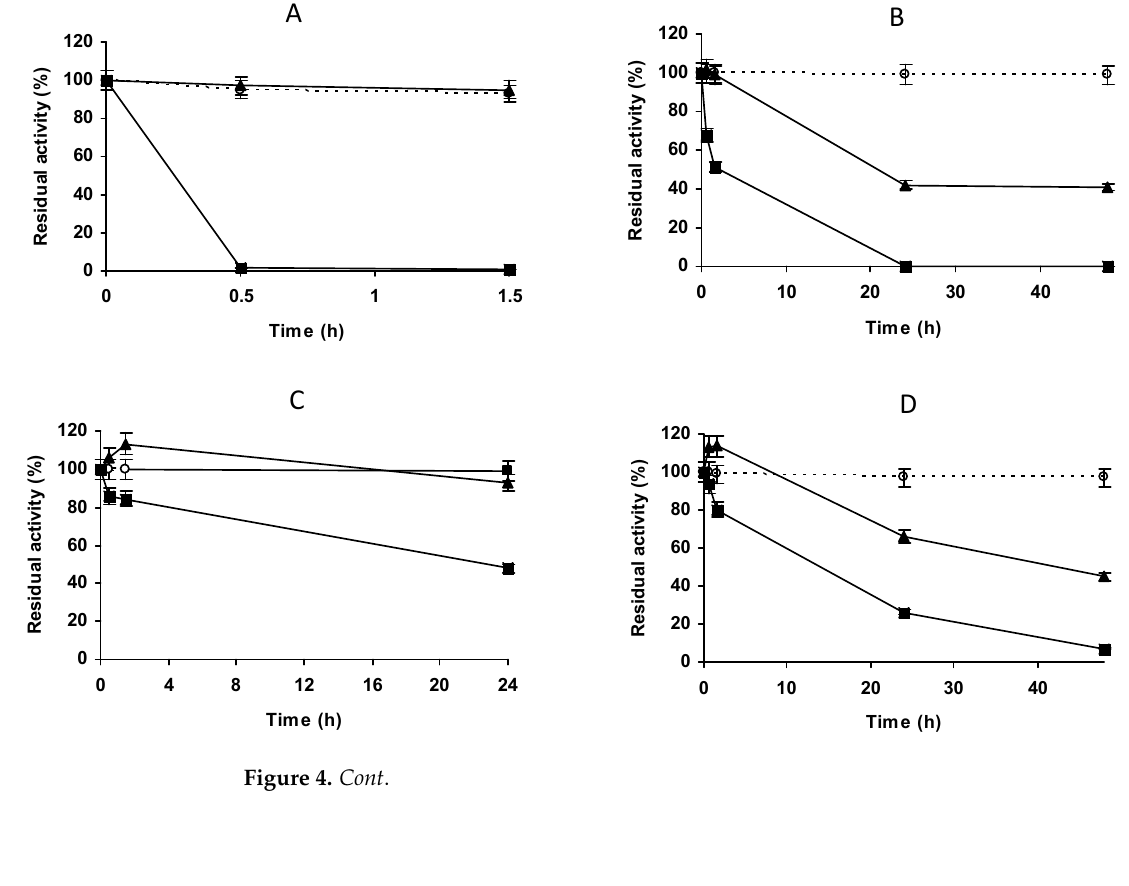
Figure 4. Immobilization courses on glyoxyl agarose ( A ) and on vinyl sulfone agarose at different concentrations of sodium phosphate at pH 8.0, 25 °C. ( B ) 25 mM; ( C ) 250 mM; ( D ) 500 mM; ( E ) 1 M. Empty circles with dashed line: reference suspension. Full triangles with solid line: suspension. Full squares with solid line: supernatant. Other specifications are described in Methods.